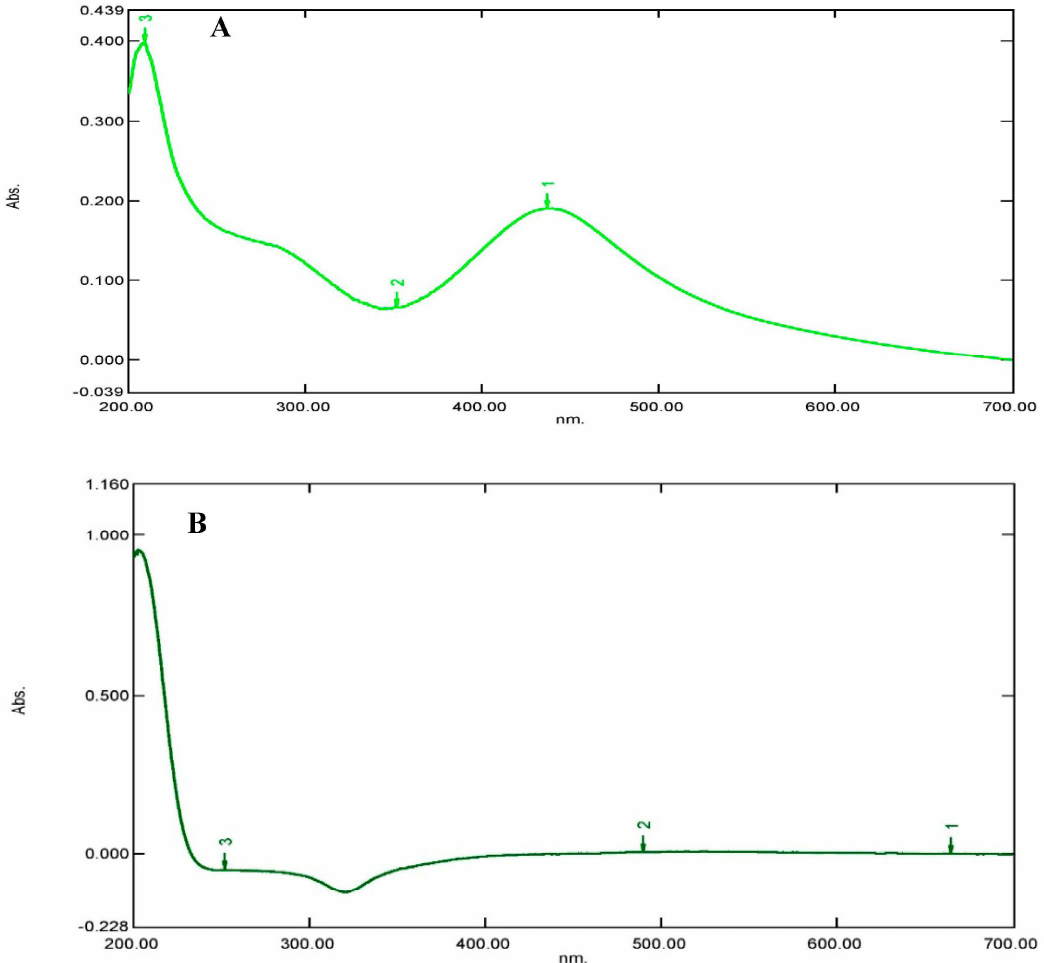
Figure 3. UV–visible spectra of ( A ) Pantoea stewartii - and ( B ) Priestia aryabhattai -synthesized silver nanoparticles.